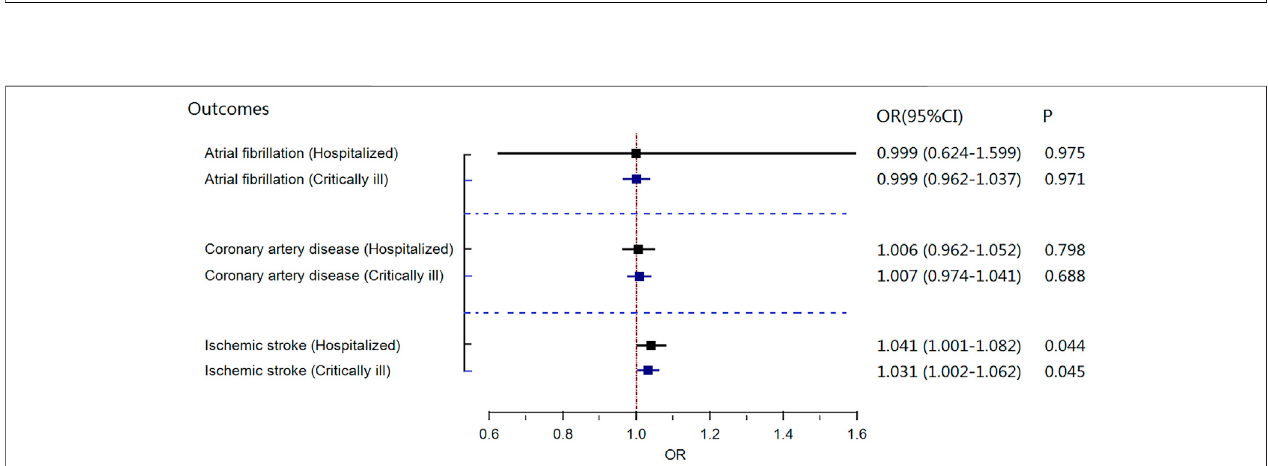
FIGURE 1 | Results of the random effects Mendelian randomization inverse-variance weighted (MR IVW) model investigating the causal association between gene-predicted severe coronavirus disease 2019 (COVID-19) and risk of three cardiovascular diseases in COVID-19 genome-wide association study (GWAS) data. CI, con fi dence interval; OR, odds ratio; MR, Mendelian randomization; COVID-19, severe coronavirus disease 2019.